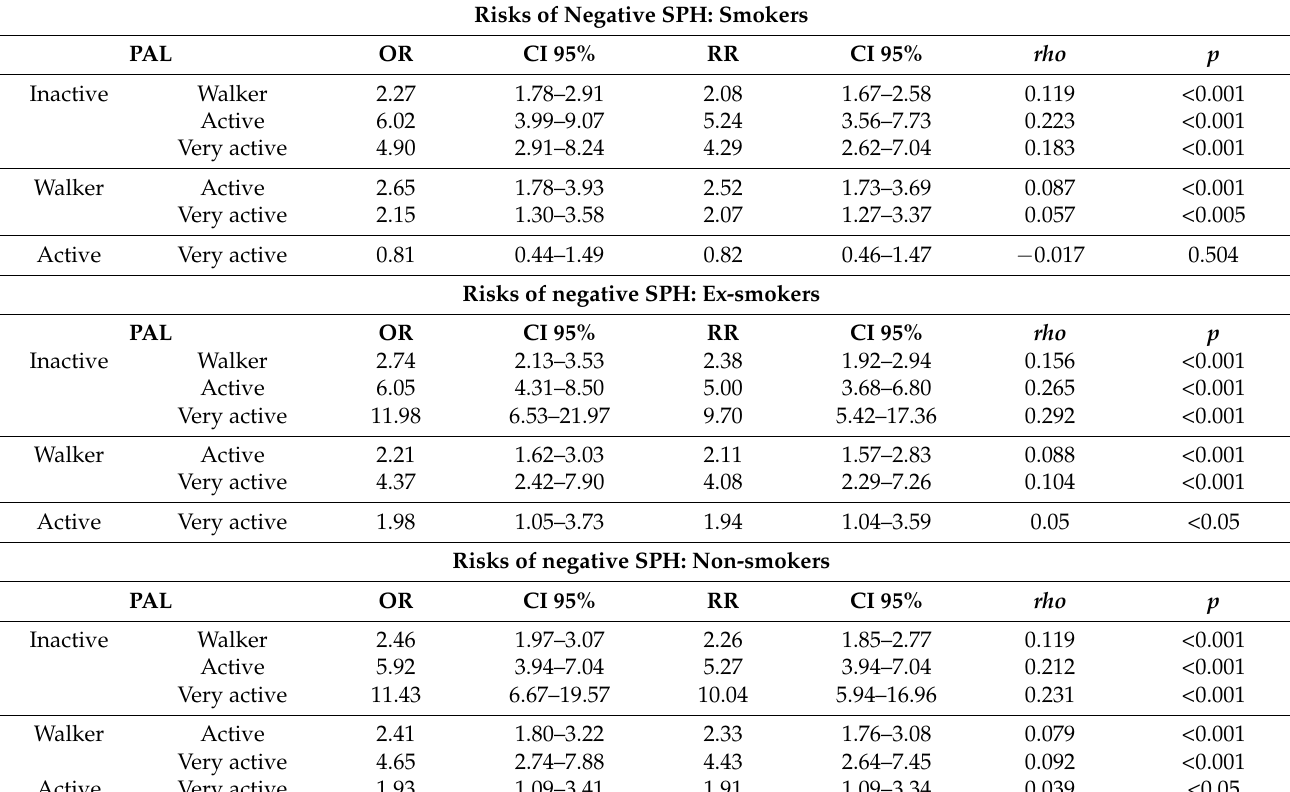
Table 4. Odds ratio and relative risk of perceiving negative health by physical activity level in the Spanish population in smokers, ex-smokers, and non-smokers in the Spanish population of the ENSE 2017. Risks of Negative SPH: